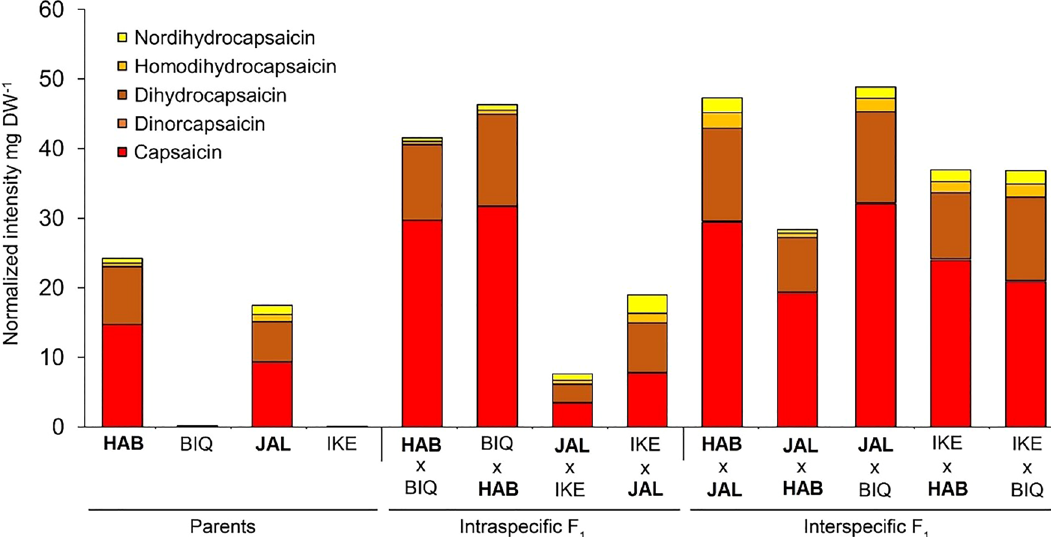
Figure 2. Relative capsaicinoid content in the placenta of intra and interspecific hybrids of Capsicum . Parents: C. chinense cv. Habanero (HAB), C. chinense cv. Biquinho (BIQ), C. annuum cv. Jalapeño (JAL) and C. annuum cv. Cascadura Ikeda (IKE). The pungent genotypes are shown in boldface. Each column represents a genotype (n = discernible and clear-cut between hot and sweet varieties, while amino acids clustered together and displayed a signature that was mostly associated with species rather than variety in the placenta (higher accumulation was observed in C. annuum varieties than in C. chinense ones) (Fig. 1A). The metabolic signature of the pericarp, on the other hand, was less consistent. Residual capsaicinoid levels were also found in the hot varieties, and metabolite accumulation displayed higher variation between individual replicates than for the placenta (Fig. 1B). The most abundant capsaicinoids were capsaicin (C 17 H 27 NO 3 , [M + H] + = 306.206356, dinorcapsaicin (C 16 H 23 NO 3 , [M + H] + = 278.175056) and dihydrocapsaicin (C 18 H 29 NO 3 , [M + H] + = 611.405446), which accounted for over 90% of total capsaicinoid content in all genotypes (Fig. 2). Small amounts of homodihydro- capsaicin and nordihydrocapsaicin were also detected. As expected, HAB had the higher total capsaicinoids level in the placenta, followed by JAL, whereas these compounds were not detected in the sweet peppers BIQ and IKE (Fig. 2). Notably, all hybrids were pungent, regardless of their parental genotypes and, except for the intraspecific hybrids of C. annuum, all combinations displayed significant degrees of both relative mid-parental heterosis (rMPH) and relative best-parent heterosis (rBPH) for all of the main capsaicinoids (Table 1). We found considerable heterotic effects specifically for capsaicinoids accumulation in the placenta of both intra- and interspecific hybrids, including those derived from non-pungent parents (BIQ and IKE) (Table 1). The intraspecific cross of the hot (HAB) and sweet (BIQ) varieties of C. chinese led to roughly twice the con- centration of capsaicinoids relative to the hot parent (Fig. 2), with little effect of parent of origin. In contrast, the hybrids between hot (JAL) and sweet (IKE) varieties of C. annuum did not produce significant increases in pungency relative to JAL when this genotype was used as pollen donor, but led to a reduction in half in capsai- cinoids concentration in the reciprocal (JAL × IKE) cross. Heterotic effects in capsaicinoids accumulation in the placenta were more evident when analysing interspecific hybrids (Fig. 2). Heterosis in the HAB × JAL hybrids was strongly depedent on parent of origin: whereas using HAB as a pistilliate (i.e. female) parent led to doubling of the pungency of the hottest parent (HAB), the hybrids derived from the reciprocal cross showed similar capsaicinoids levels as HAB. Lastly, in the three combinations of crosses for which reciprocal hybrids were not viable (JAL × BIQ; IKE × HAB; IKE × BIQ), considerable heterosis for capsaicinoids accumulation was observed: the JAL × BIQ hybrid had triple the levels of the hot parent (JAL), the IKE × HAB hybrid around 50% more than HAB and, remarkably, the hybrid derived from non-pungent parents (IKE × BIQ) displayed high accumulation of capsaicinoids (Fig. 2). By contrast, the pericarp metabolites of interspecific hybrids showed mid- to strong hybrid depression, except for several amino acids from the HAB × JAL combination (glycine, threonine, branched-chain and aromatic amino acids, lysine, aspartate, asparagine, GABA, pyroglutamic acid and GABA). Here, most primary metabo- lites, whether from placenta or pericarp, generally showed non-additive accumulation patterns (i.e., their levels being significantly lower or higher with respect to the best parent), with few cases of reciprocal effects detected for amino acids in the placenta of the intraspecific cross of C. chinense. We then mapped the metabolite rBPH values onto the main pathways of primary metabolism and found that a few general trends emerged (Fig. 3). For the intraspecific crosses, where the diallel crosses allowed us to compare between the reciprocal effects of parents (i.e. differences in rBPH in hybrids derived from the same parents used in different male/female combinations), we observed marked parent-of-origin effects on the level of several metabolites. Among these, the most notable were amino acids, e.g., serine, valine, aspartate, GABA and pyroglutamic acid in the placenta of the fruits derived from the intraspecific C. chinense crosses (i.e., HAB × BIQ